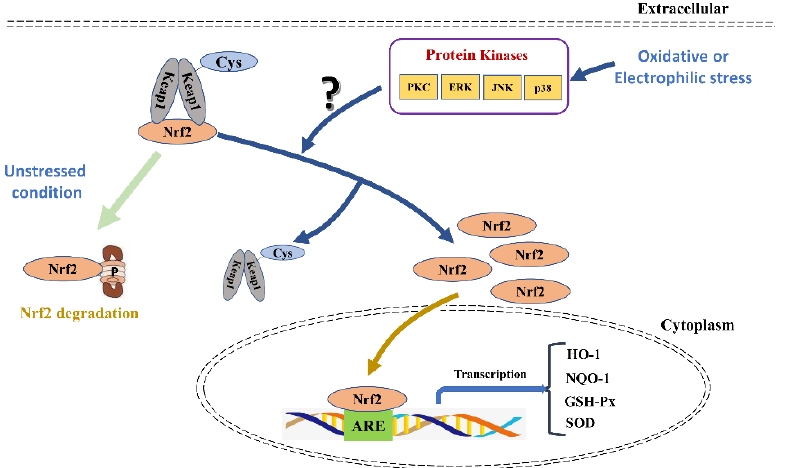
Figure 2. The role of Nrf2/ARE pathway in antioxidant response and its regulatory mechanism. In unstressed condition, Nrf2 synthesized in the cell is primarily bound to a complex with Keap1 and degraded by the 26S proteasomes. After oxidative or electrophilic stress, Keap1 molecules become saturated with Nrf2, and the number of newly synthesized, free Nrf2 is increased and promotes its translocation to the nucleus. In the nucleus, binding of Nrf2 to the ARE is facilitated and transcription of a wide variety of downstream are stimulated, which play an important role in cytoprotection and metabolism.